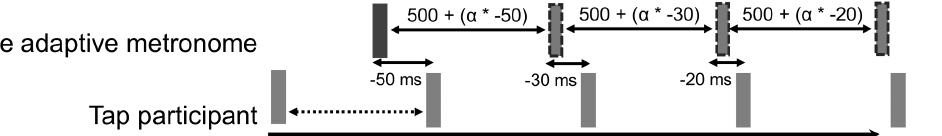
Figure 1. Pacing signal for the adaptive tapping task. The timing of the pacing signal was determined by the following equation: t n + 1 = t n + 500 + a 6 asyn n . In the current experiment a was set to 0, 0.3 or 0.7, thus the pacing signal corrected 0 (non-responsive metronome in fixed trials), 30 or 70% of the asynchrony by shifting the next tone in the opposite direction.